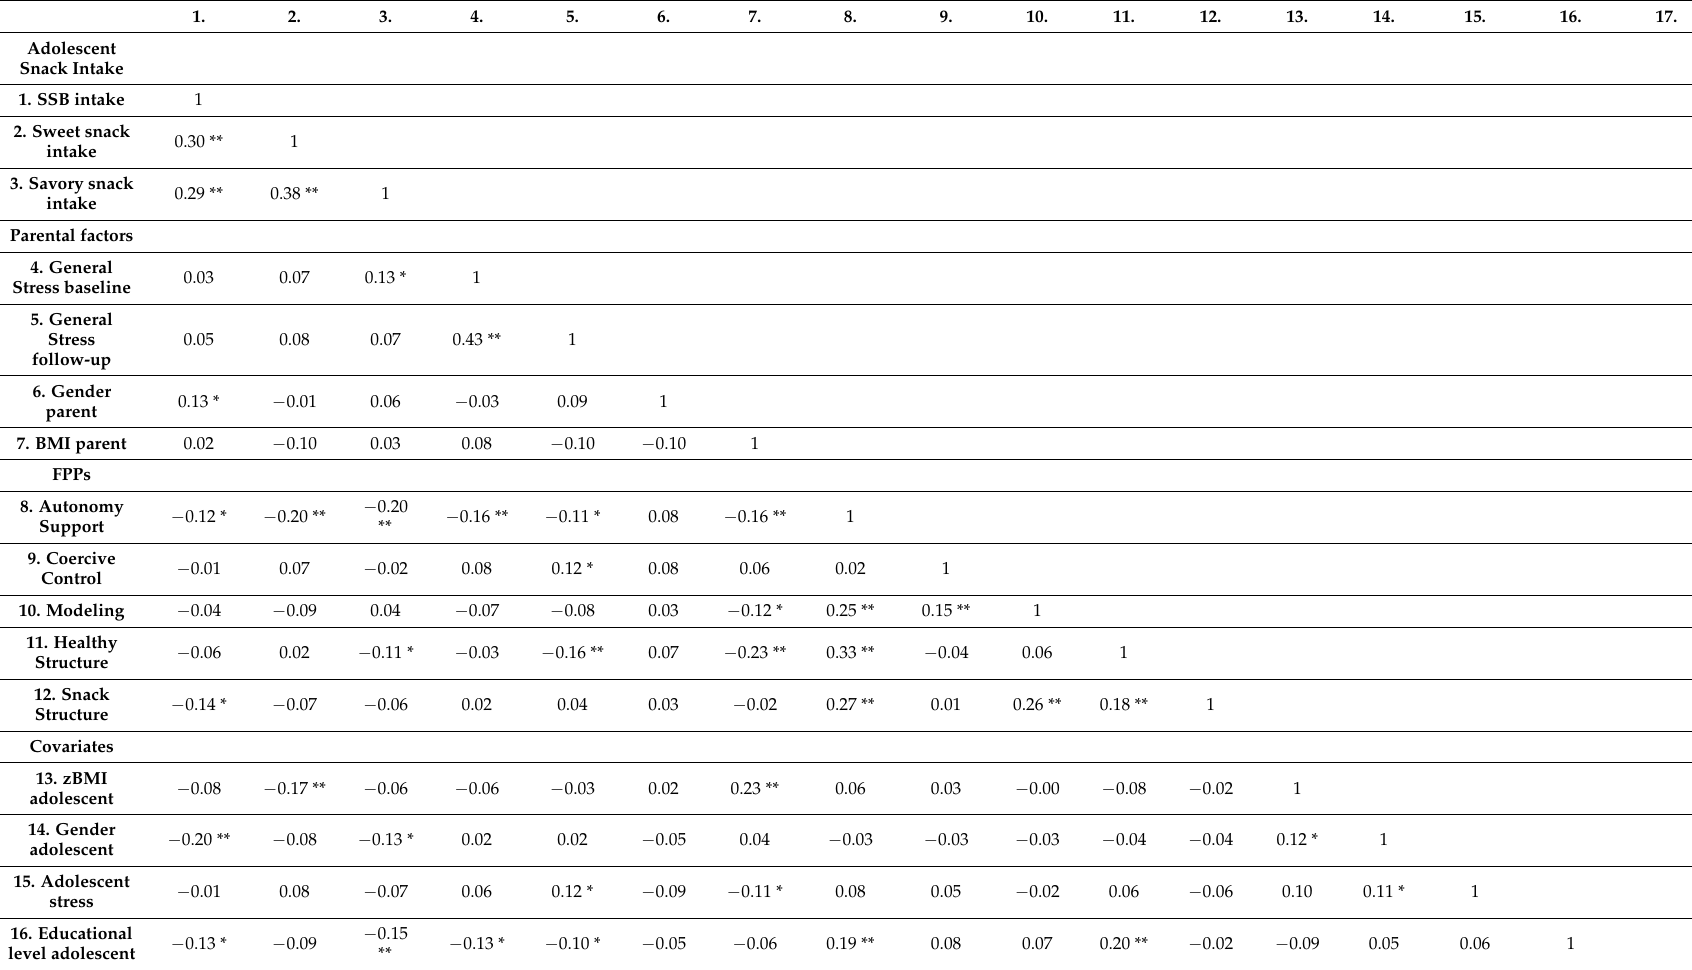
Table 2. Correlational associations between adolescent snack intake at follow-up, parental factors at baseline and follow-up, and parental FPPs at